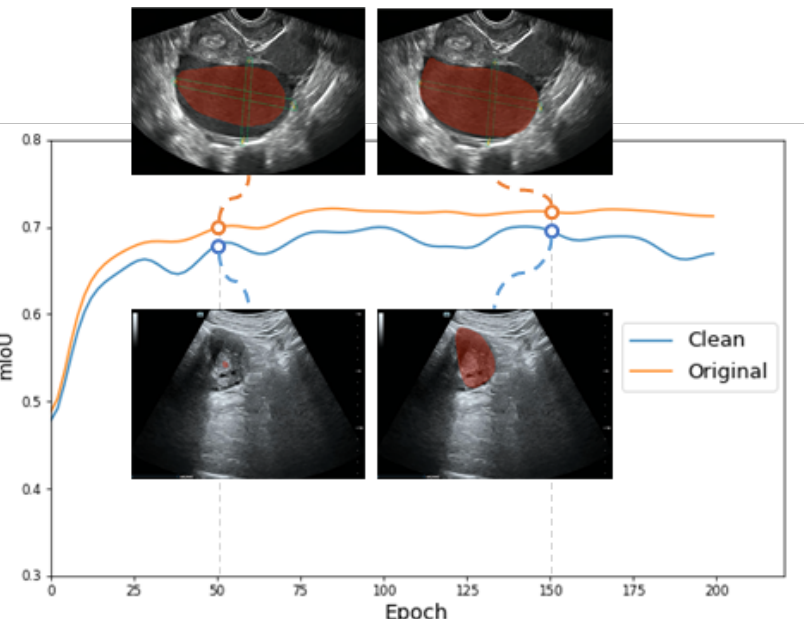
Figure 2. The accuracy graph of lesion segmentation of the Unet [19] model. The blue line represents the accuracy of using the clean images as the testing set. The yellow line represents the accuracy of using the original images with symbols as the testing set. The figure also shows the visualization of the segmentation results for the 50th and 150th